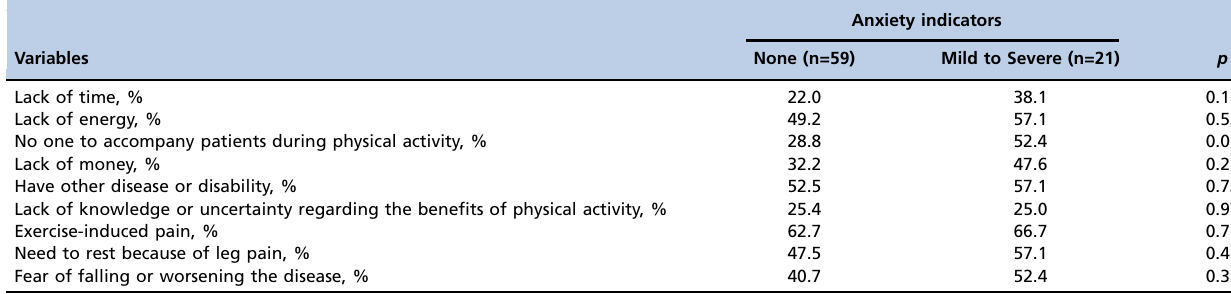
Table 4 - Association between barriers to physical activity and anxiety symptoms